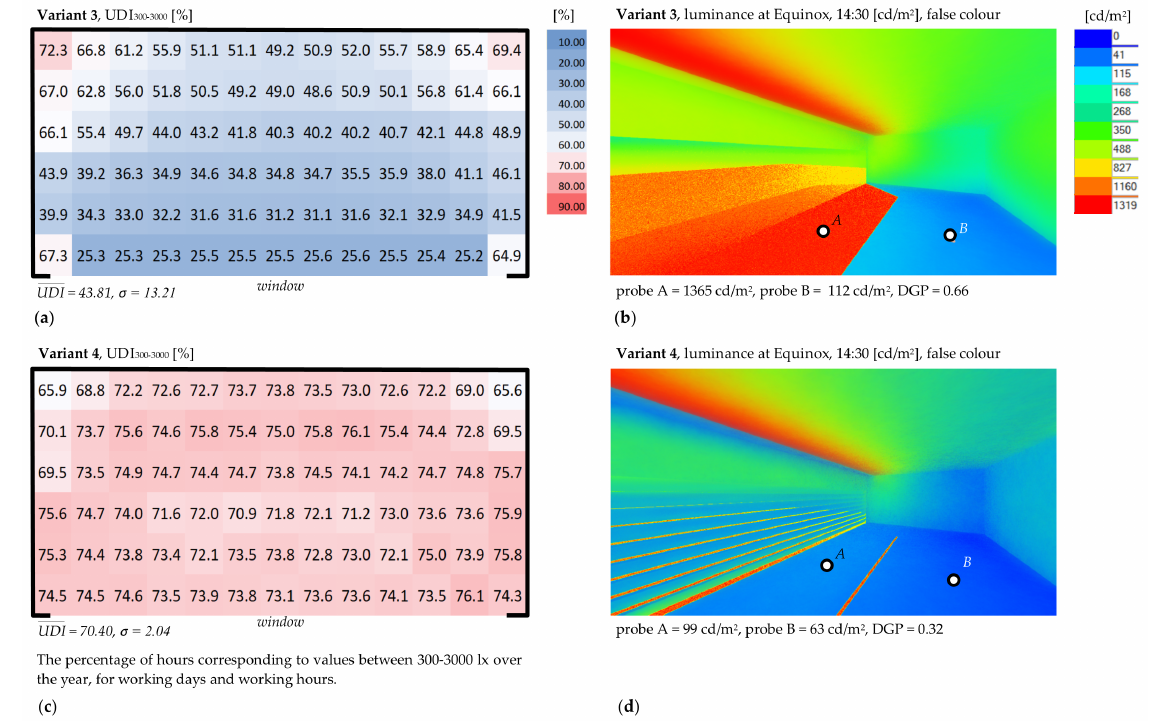
Figure 6. Results of the second phase of the simulation: ( a , c ) test room plan and spatial distribution of UDI 300–3000 over the test year (%); ( b , d ) luminance values for equinox, at 14:30 (cd/m 2 ) for Variants 3 and 4. Scale is given respectively on the Figure. Exact values are given in the data file in Supplementary Materials.